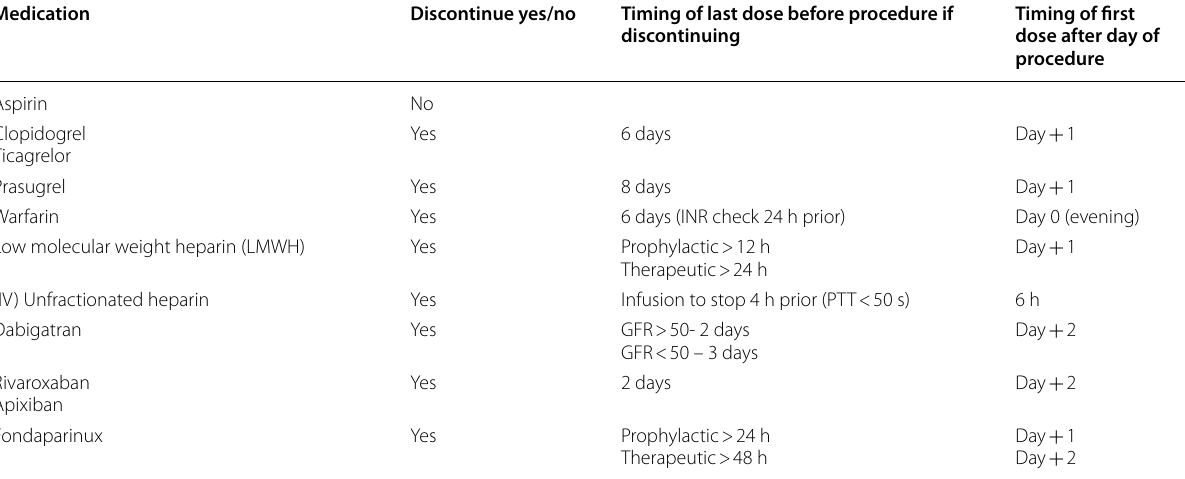
Table 2 Pre-procedural anti-platelet and anticoagulation